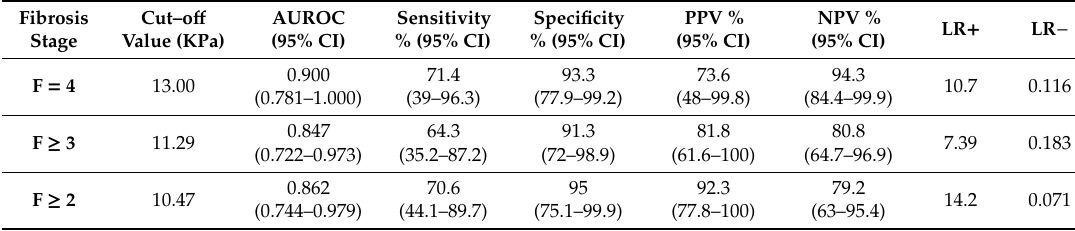
Table 4. Diagnostic performance of 2D-SWE (ElastQ) in patients aged ≥ 65 years. Fibrosis